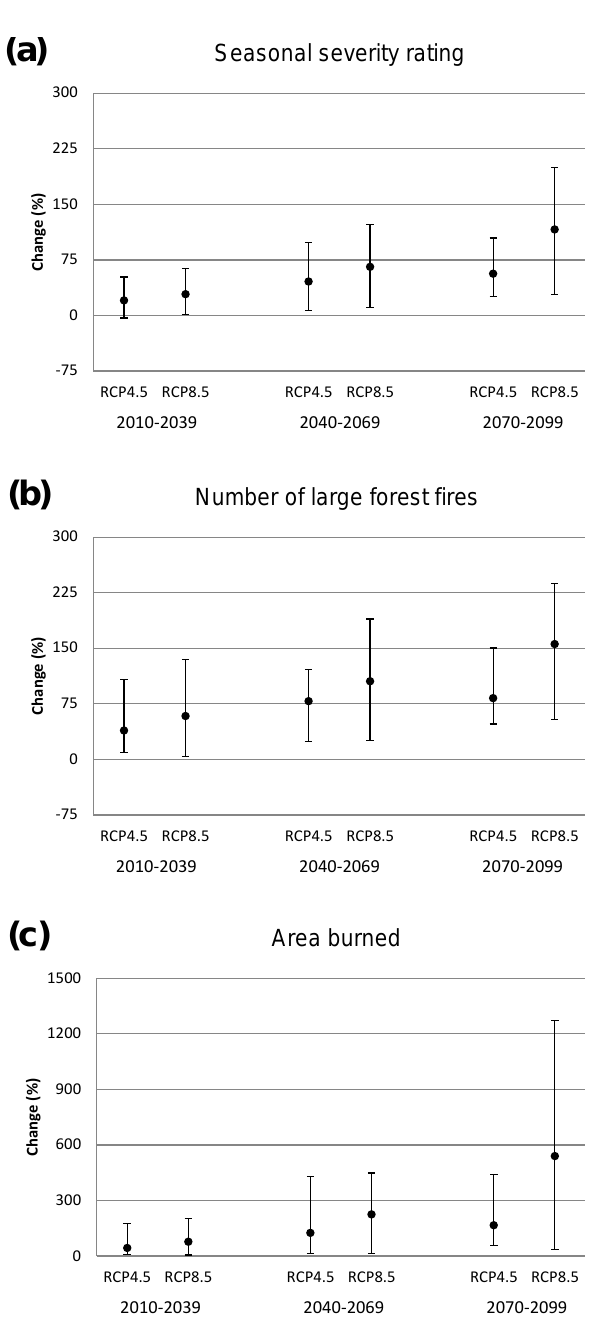
Table 4. Proportions (in %) of forest fires of different sizes, divided according to the daily severity index (DSR) classes in Finland dur- ing 1996–2014.